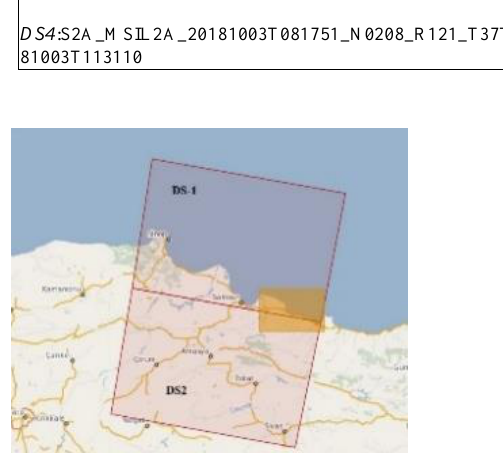
Figure 4. The methodological workflow of the flood extent mapping